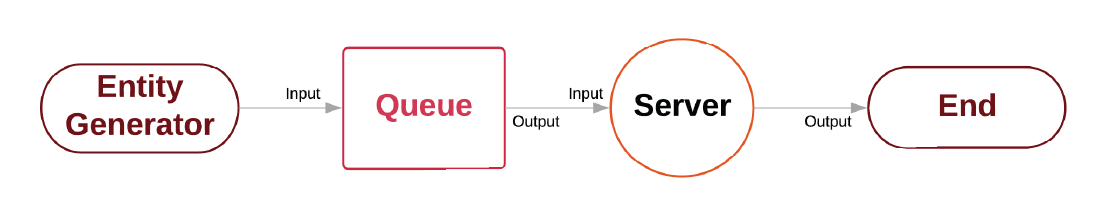
Figure 1. Flowchart depicting the flow and the main components of a discrete event